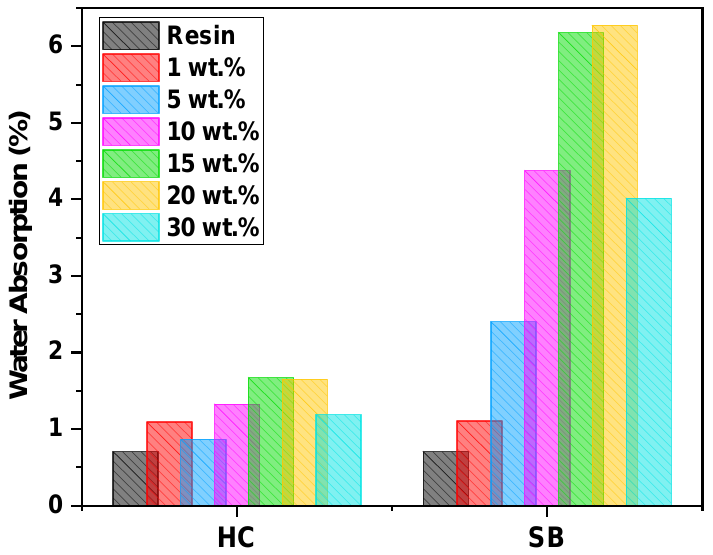
Figure 8. Water absorption of the ELO/HC and ELO/SB polymeric materials after 11 days of immersion in deionized water at room temperature .